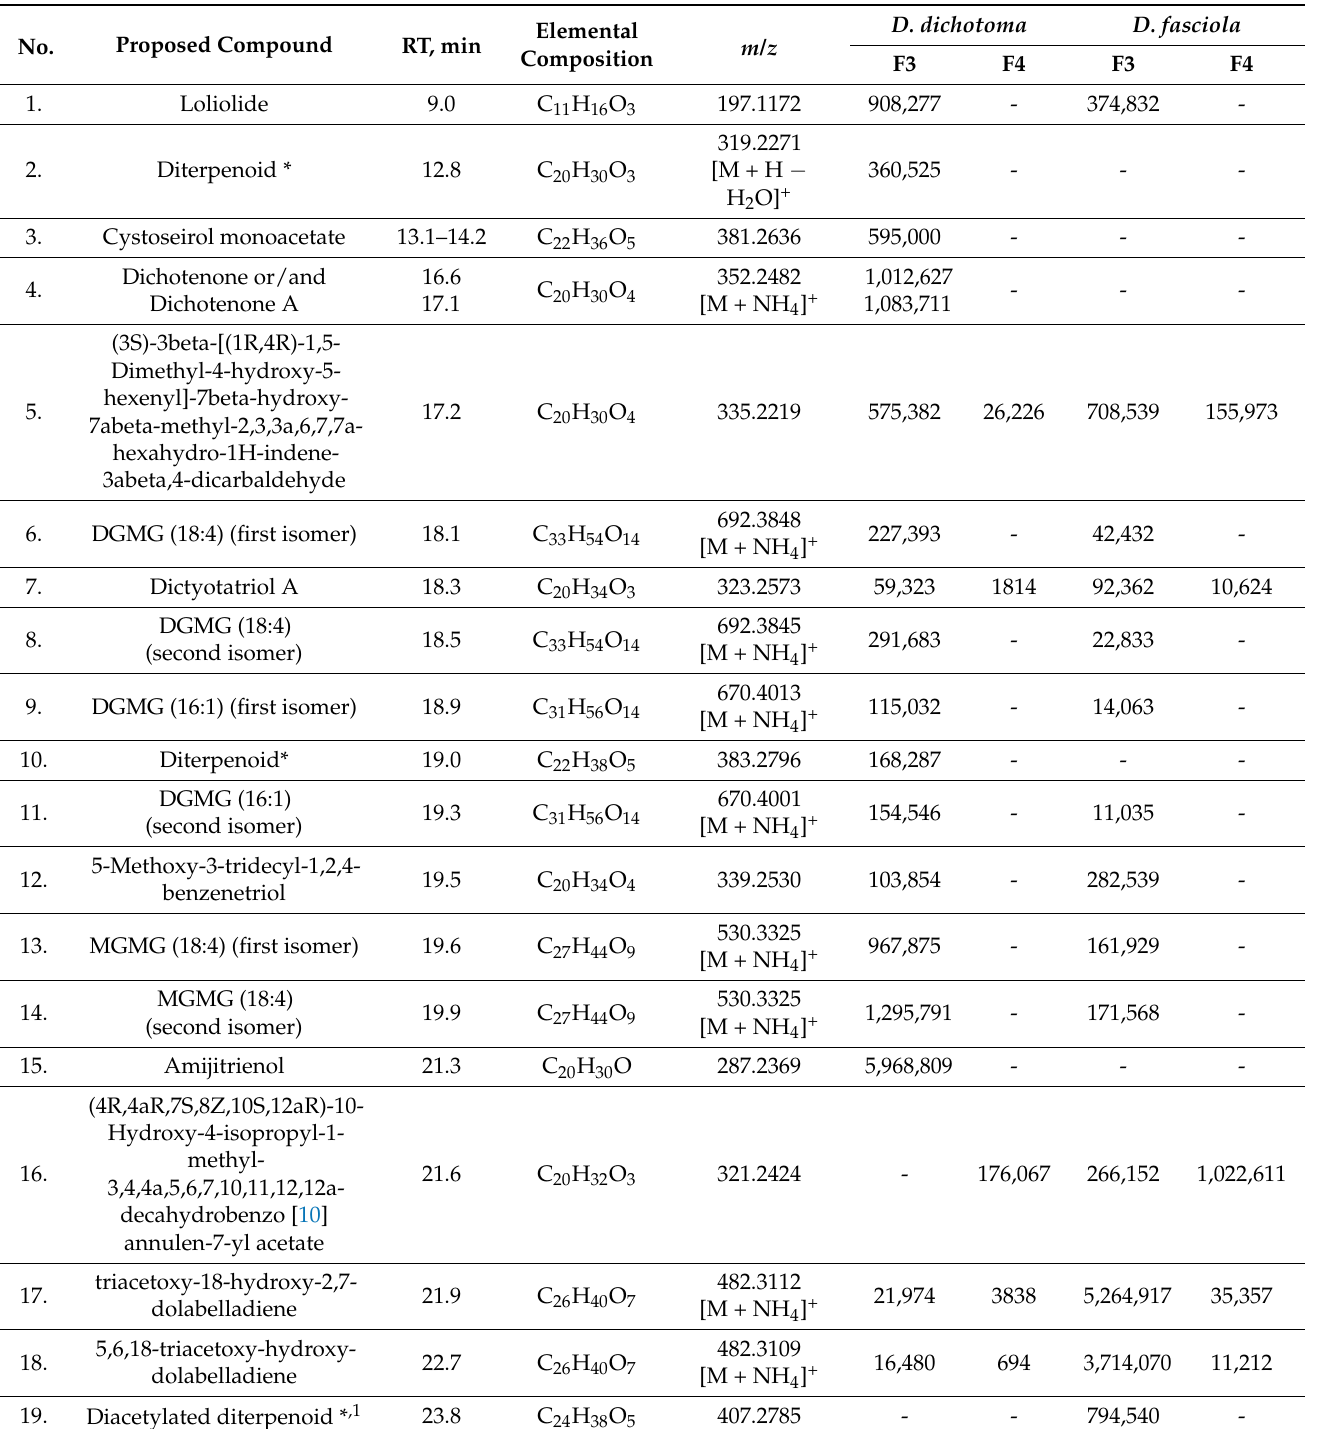
Table 3. Major non-polar molecules identified in D. dichotoma and D. fasciola by LC-MS/MS